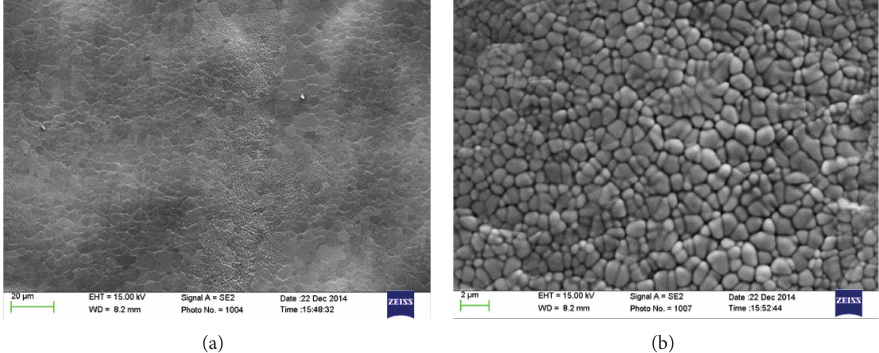
Figure 2: Surfaces of the ribbons after rapid quenching: (a) grain diameters of about 5 𝜇 m and (b) grain diameters of about 0.5 𝜇 m.